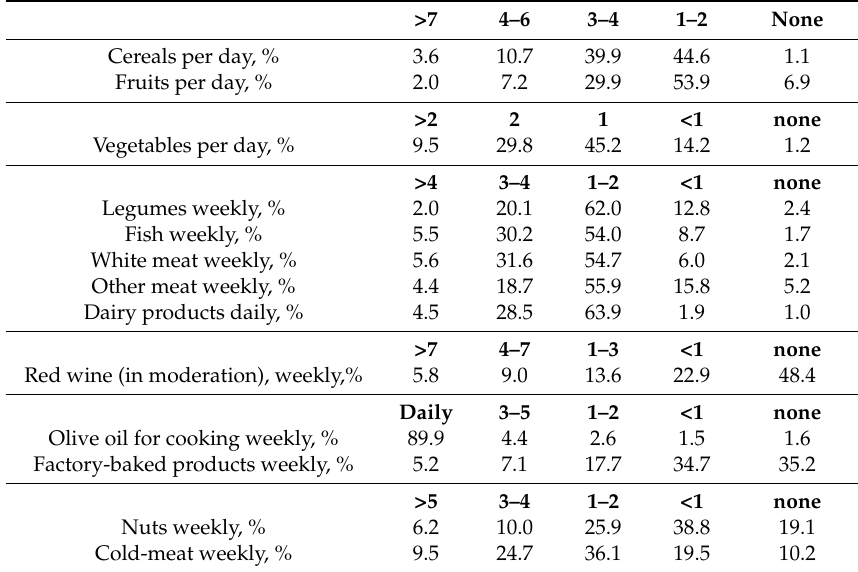
Table 3. Mediterranean intake habits in the total population ( n =